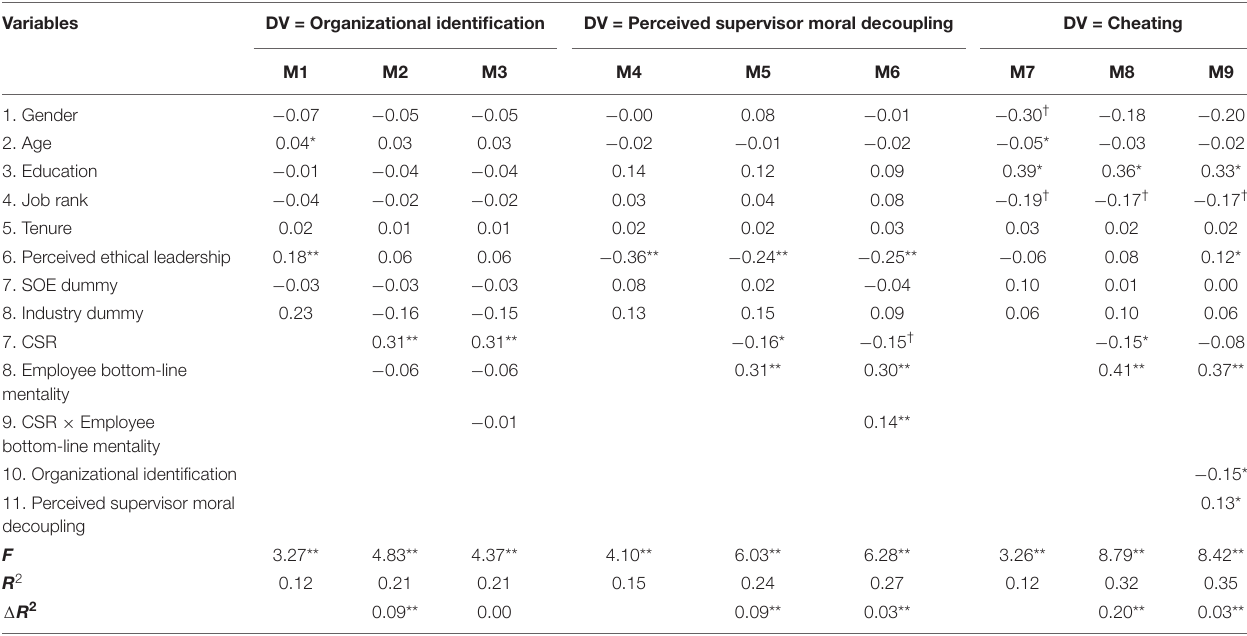
TABLE 3 | Regression